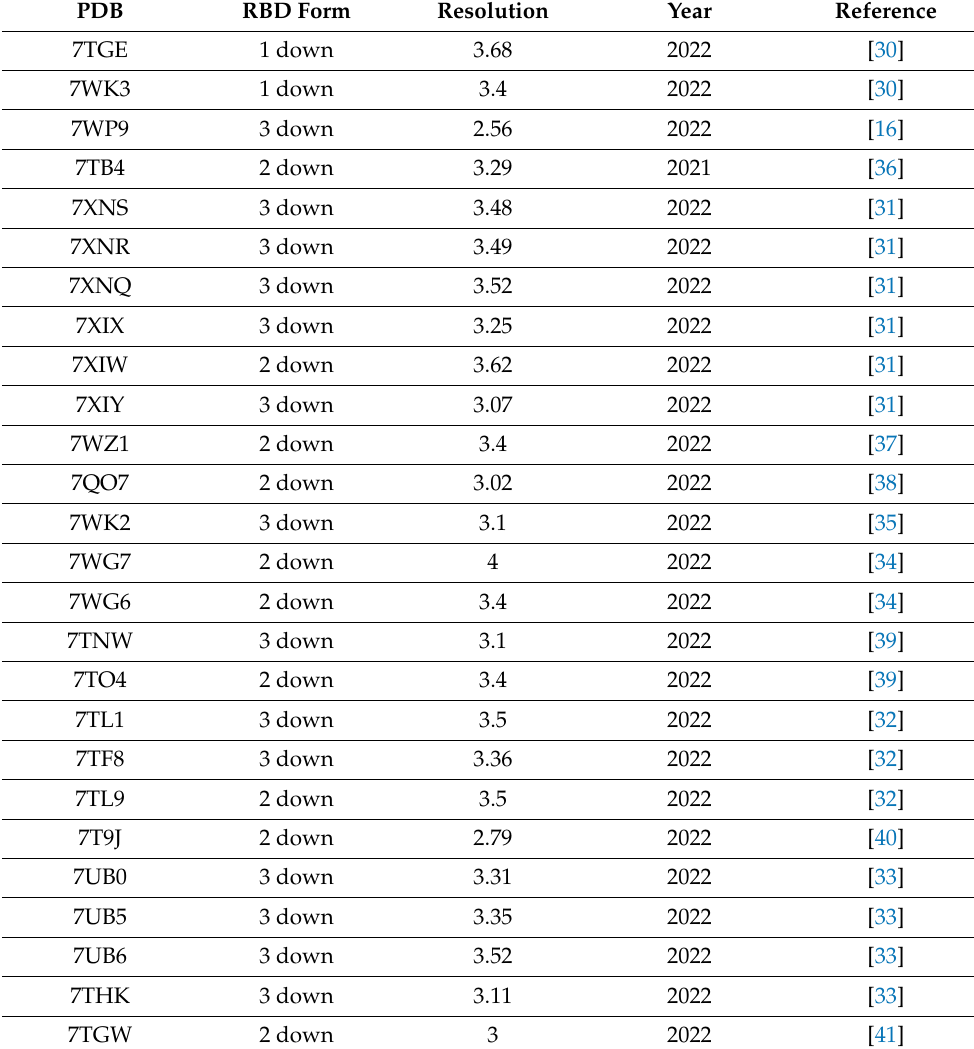
Table 1. Three-dimensional structures of full-length Omicron spike protein characterized by electron microscopy and the receptor binding domain (RBD) conformation status.